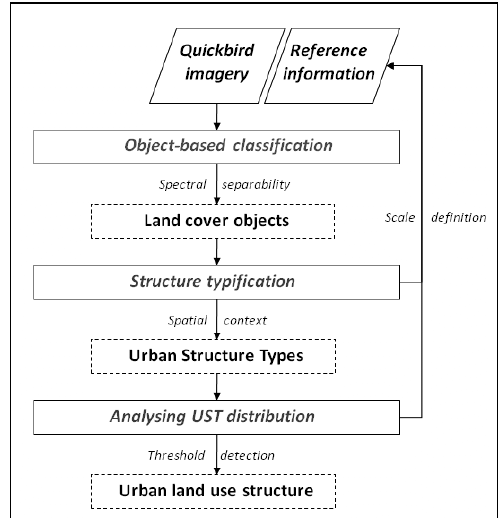
Figure 3. Workflow to derive urban land use